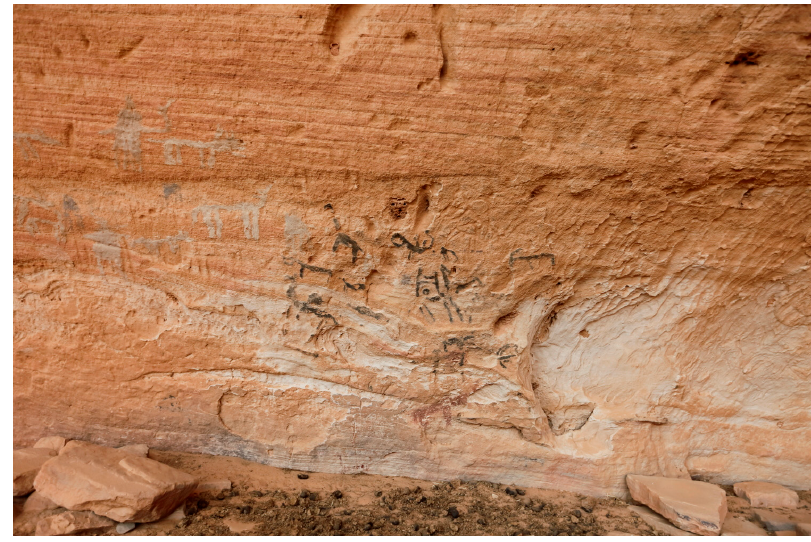
Figure 6. Schematic camels and undeterminable quadrupeds painted on the bottom wall of the shelter at P1 (Photo: Alessandro Menardi Noguera).